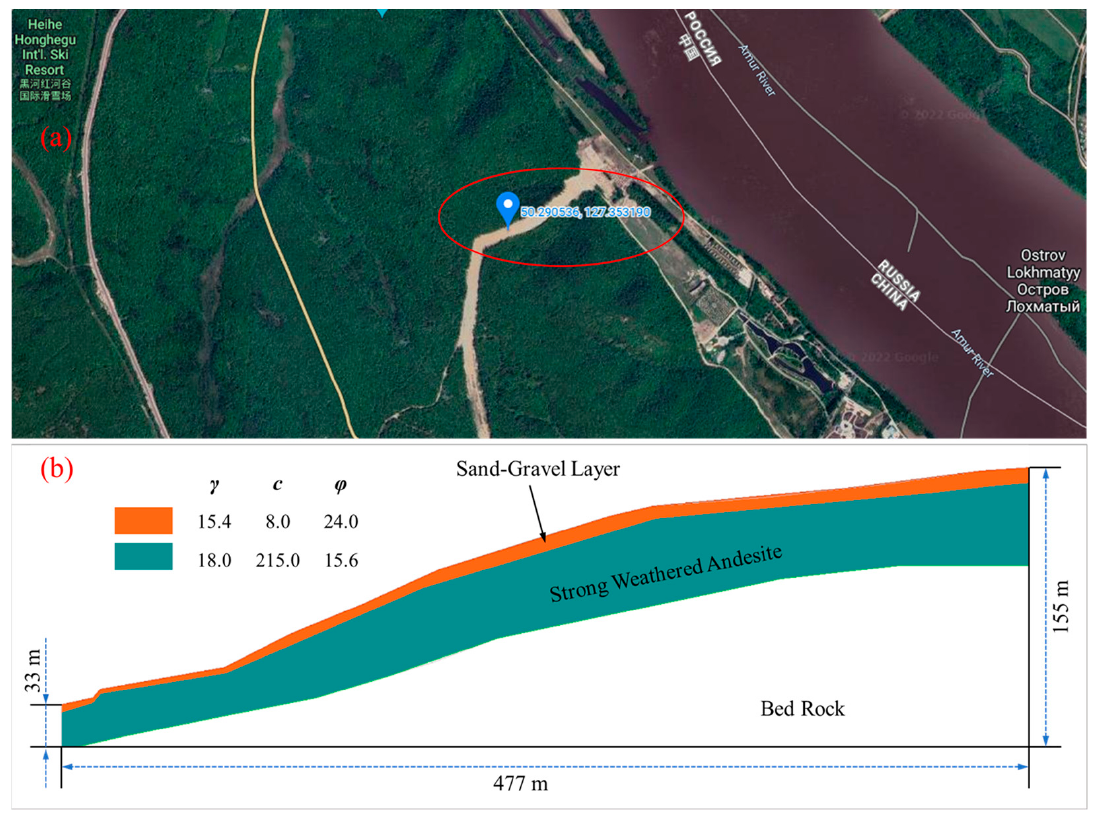
Figure 8. ( a ) Locations of the Pile AA001–AA004 and the monitoring slope. ( b ) Stratigraphic model of the monitoring regional landslide. Table 6. Shear strength of rock mass varying with water content.